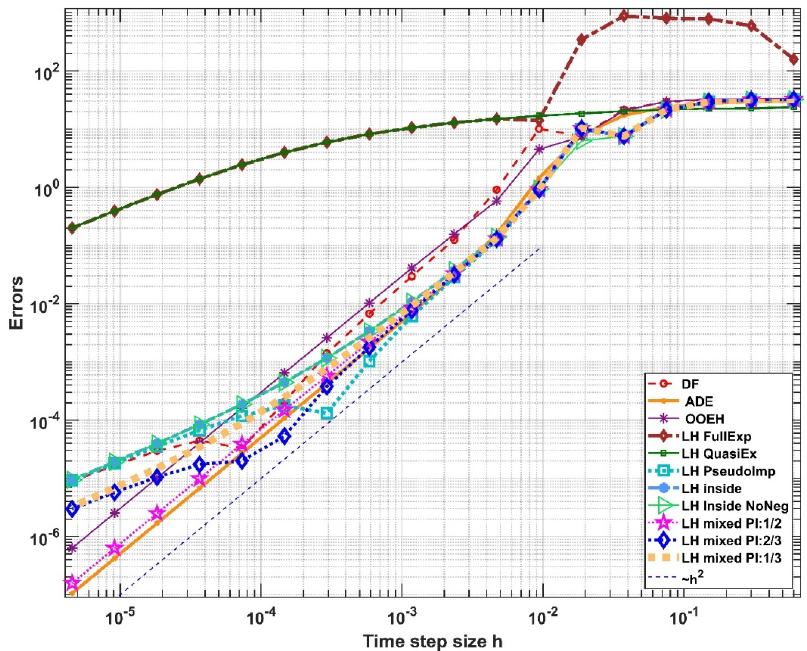
Figure 2. The L ∞ errors as a function of the time step size h for large K (Experiment 1). In Figure 3, we also present the initial and final temperatures for the LH method for h = 9.38 · 10 − 3 . In this case, the maximum error of the “inside” implementation is 0.949, while it is 0.926 for the mixed method. One can observe that the numerically obtained functions are very similar to the reference solution, even in the case of these rather large (absolute) errors.